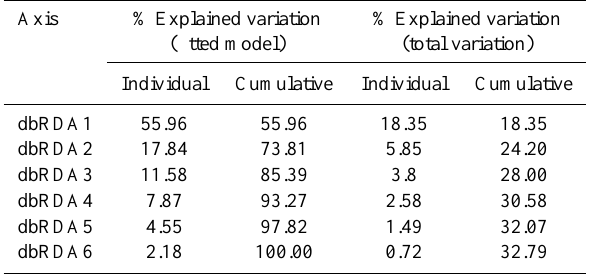
Table 4. Results of distance-based multivariate linear model (Dis- tLM) for bacterial community composition in epi-, meso- and bathypelagic seawater layers showing the % variation explained by individual axes. The first two columns relate to the percentage ex- plained out of the fitted model (individuated with the DistLM anal- ysis). The second two columns relate to the percentage explained out of the total variation in the resemblance matrix used to build up the DistLM